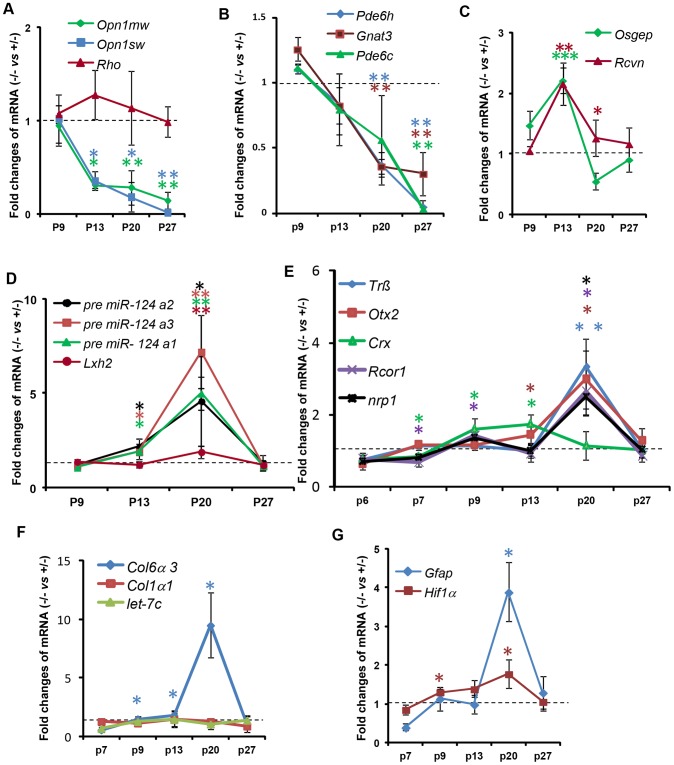
Temporal profiles of changes in gene expression by ablation of Ranbp2 in cone photoreceptors.(A–G) qRT-PCR of cone-specific (A, B), pan-photoreceptor (C), cone survival (D) and cone transcription factors (E), col6α3 and col1α1 (F), and Gfap and Hif1α transcripts (G). There is a decrease of cone-specific transcripts beginning at P13 (A, B), whereas pan-photoreceptor (C) and cone survival genes (D) begin transient up-regulations at the same age. The expression of cone survival genes peaks at P20 (D). (E) The transcription factors, Crx and CoREST (Rcor1), are the first nuclear factors whose changes of their transcriptional levels coincides with the genetic ablation of Ranbp2 at P7. These events are followed by the up-regulations at P20 of the transcription factors, Nrp1, Trß2 and Otx2 (E). The up-regulations of transcripts encoding the substrate of MMP11, col6α3, begins at P9 and peaks at P20 (F), whereas those for the hypoxia marker, Hif1α, and inflammatory marker, Gfap, begin at P9 and P20, respectively (G). Legends: Data shown represent the mean ± SD, n = 3–4; *, p<0.05; **, p<0.01; ***, p<0.001; refer to table S1 for gene designations/symbols.